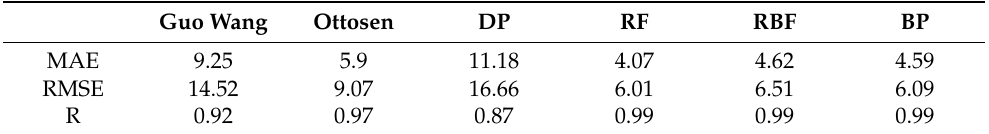
Table 1. Comparison between the neural network strength criterion model and classical strength cri-